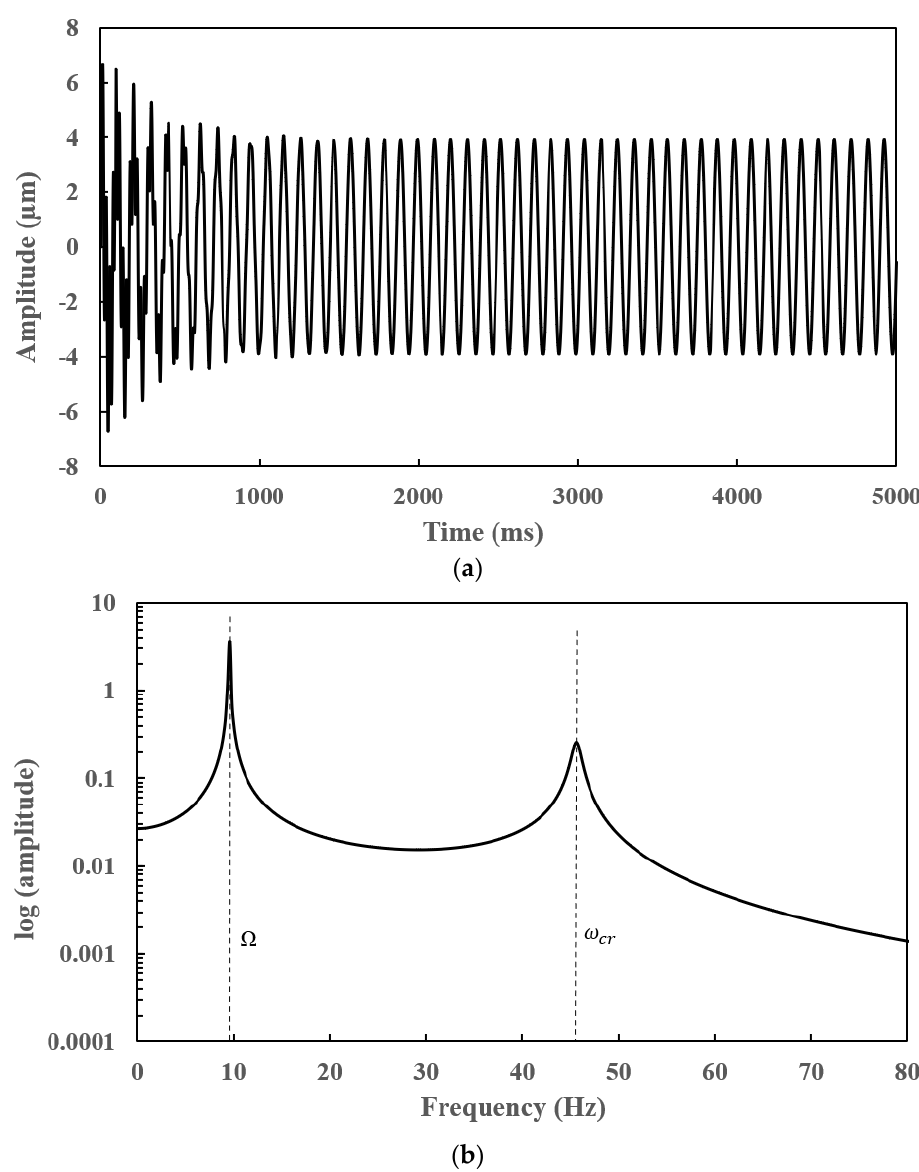
Figure 8. Steady − state ( a ) time response and corresponding ( b ) FFT of an uncracked EG rotor − bearing system with a rotor speed of 60 rad/s.